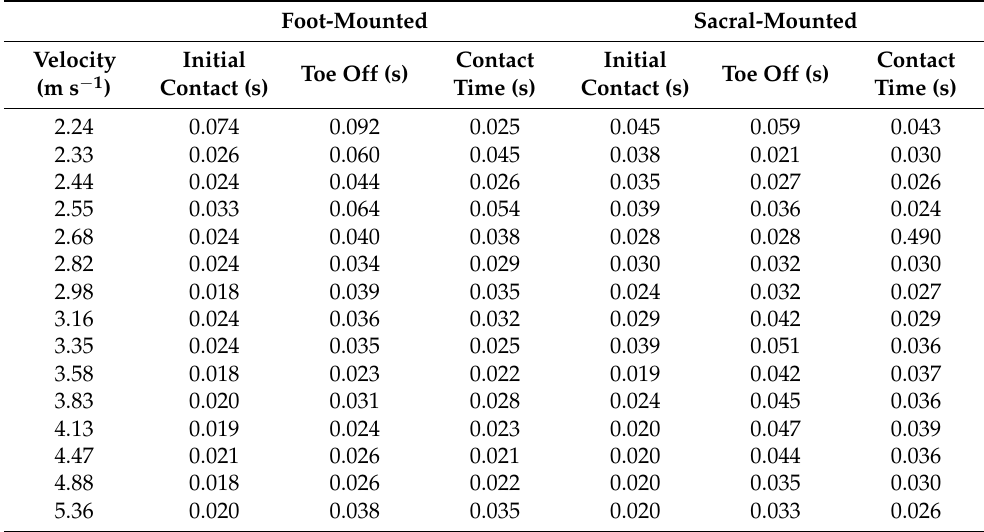
Table 3. Root-mean-square error for identification of gait events and estimation of contact time. Table 3. Root ‐ mean ‐ square error for identification of gait events and estimation of contact time. Foot-Mounted Foot ‐ Mounted Sacral ‐ Mounted